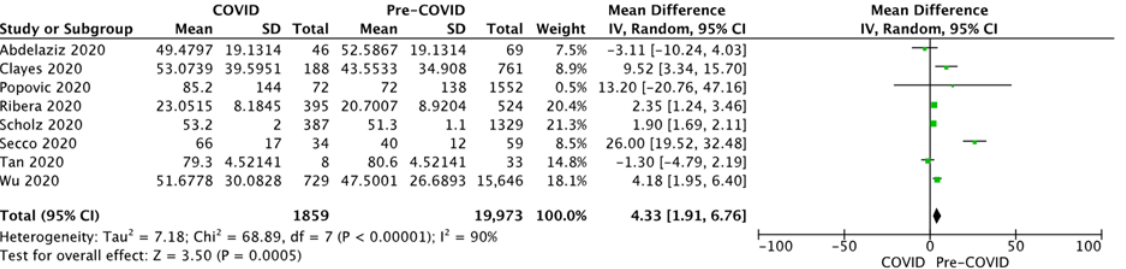
Figure 4. Forest plots for door-to-balloon time.